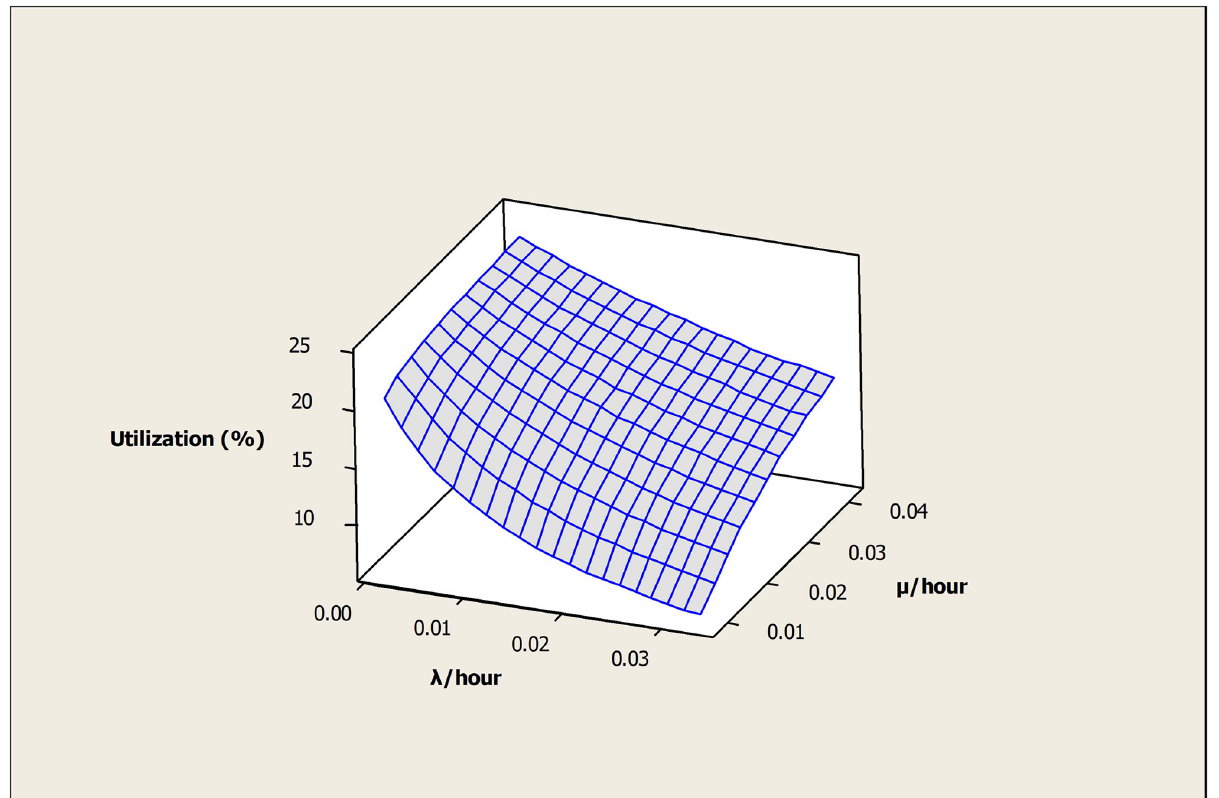
Fig 16. Surface plot of utilization (%) versus μ /hour, λ /hour.